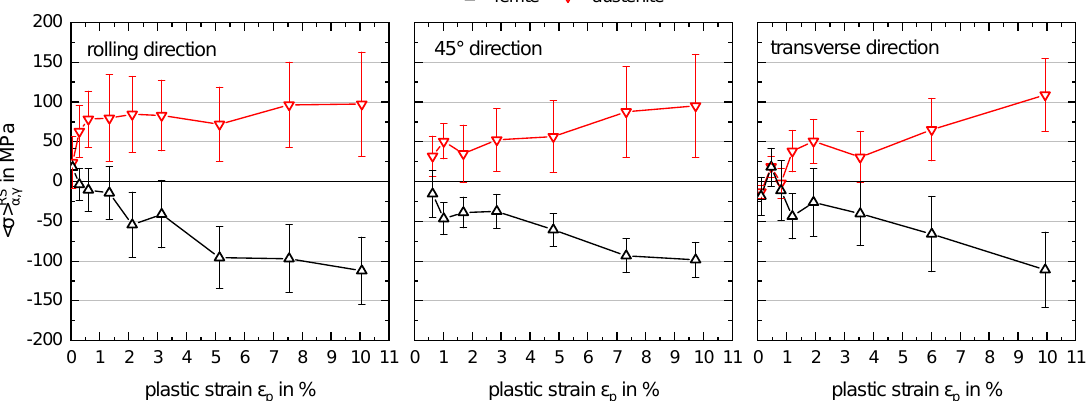
Figure 10. Evolution of phase-specific residual stress after loading in rolling direction RD ( left ), 45 ◦ direction ( centre ) and transverse direction TD ( right ).